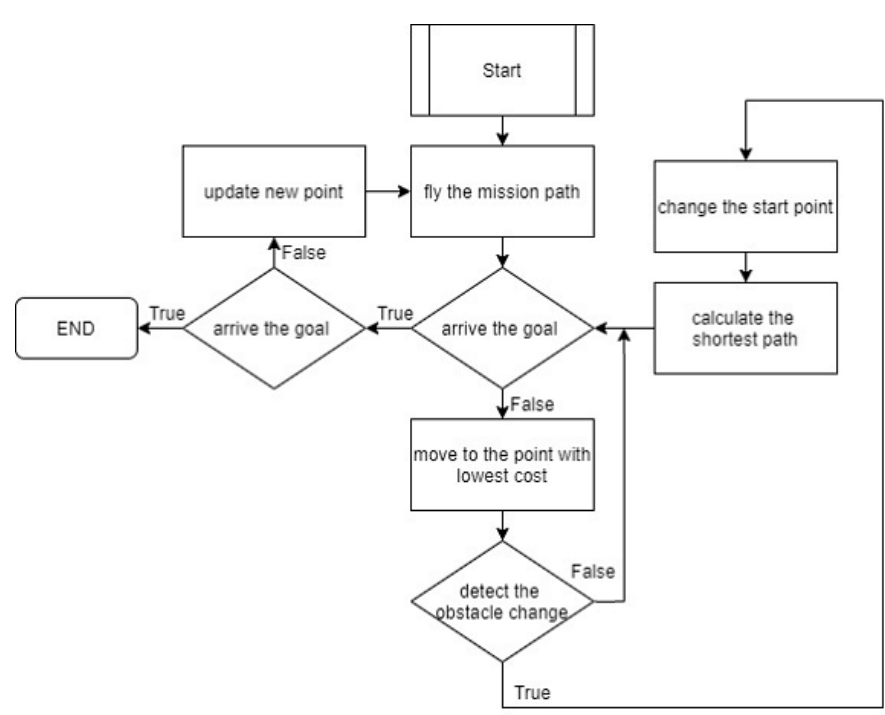
Figure 10. Modified D* Lite flow chart.